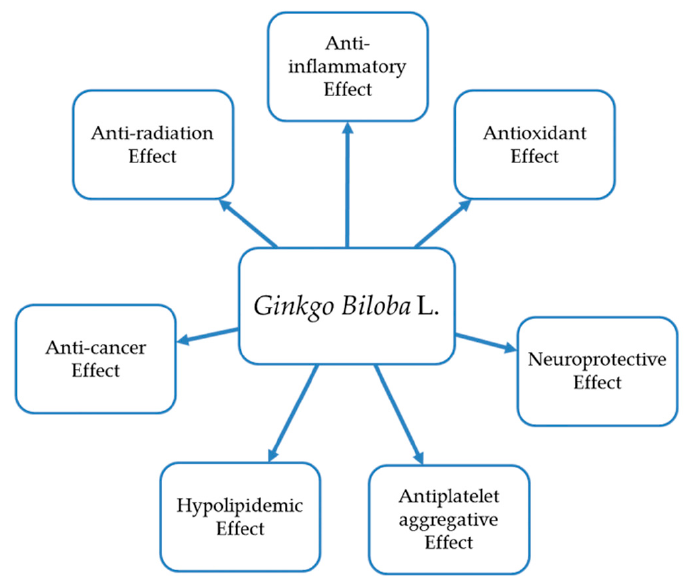
Figure 1. Bioactivity of Ginkgo biloba L.